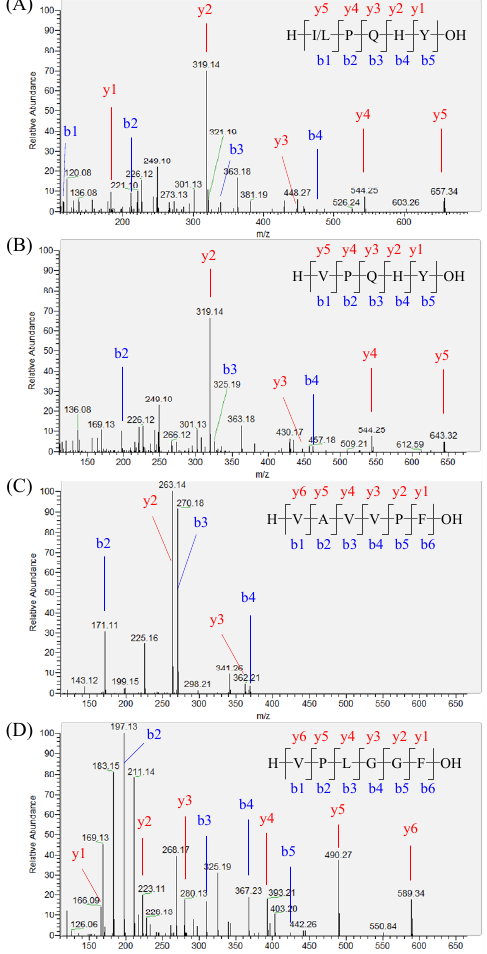
Figure 2. Identification of the oat-protein-derived peptides. The MS/MS spectra of the precursor ions with m/z at 657.33, 643.32, 631.38, and 589.33 were determined to be IPQHY/LPQHY ( A ), VPQHY ( B ), VAVVPF ( C ), and VPLGGF ( D ), respectively. Among the 10 novel peptides, only LPQYQA showed a relatively low activity, whereas the other nine peptides (IPQHY, VPQHY, VAVVPF, VPLGGF, LPQHY, VAEVPF, PPHCP, MAGQVF, and AAVPF) all exhibited superior DPP-IV inhibitory ac- tivities with a significant dose−effect at concentrations ranging from 25 μM to 400 μM ( p < 0.05, Table 3). In particular, IPQHY, VPQHY, VAVVPF, and VPLGGF had the highest DPP-IV inhibitory activities, with an IC 50 of 25.72 ± 1.06 μM, 30.78 ± 1.93 μM, 33.91 ± 4.83 μM, and 40.22 ± 0.95 μM, respectively; followed by LPQHY, VAEVPF, and PPHCP, with an IC 50 of 62.66 ± 71.25 μM, 65.33 ± 13.08 μM, and 77.14 ± 2.75 μM, respectively; and MAGQVF of 223.31 ± 6.16 μM and AAVPF of 282.31 ± 27.18 μM, respectively ( p < 0.05). Table 3. DPP-IV inhibitory activities of the oat-derived peptides. The data marked by different let- ters for each determination were significantly different ( p < 0.05). Sequence